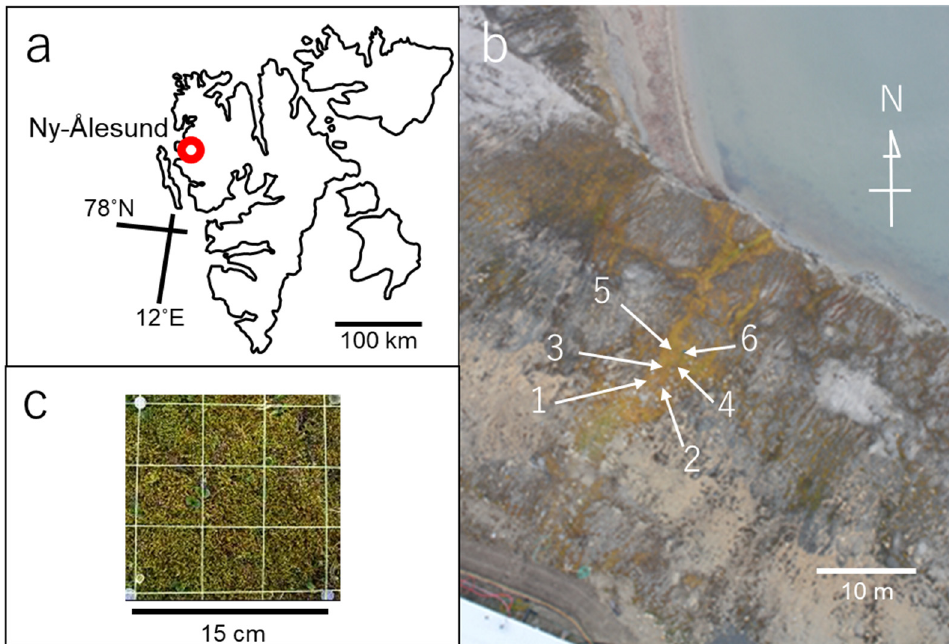
Figure 1. Study site and plot: ( a ) location of Ny-Ålesund, Spitsbergen Is., Svalbard Archipelago, Norway; ( b ) distribution of the six sampling plots (arrow heads) in the Sanionia moss colony at a north side cliff in Ny-Ålesund; ( c ) the 15 cm-square plot. The yellow threads of the quadrat were put on the moss surface only when the moss was sampled. The aerial photograph was kindly taken by Dr. Jun Inoue of the National Institute of Polar Research (NIPR).